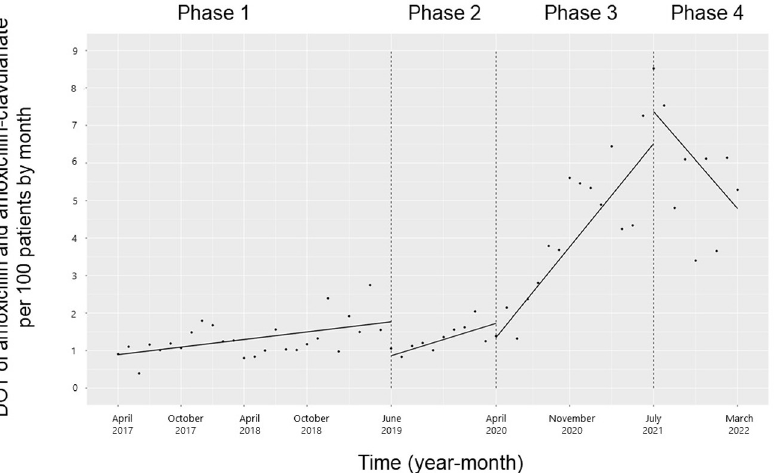
Fig 3. Trends in the days of amoxicillin and amoxicillin-clavulanate therapy per 100 patients, by month, during Phases 1 to 4. Each dot refers to the amoxicillin and amoxicillin-clavulanate per 100 patients each month, and the slope is based on the linear regression in the four phases: Phase 1 (pre-intervention period from April 1, 2017, to May 31, 2019); Phase 2 (review of clinical pathways from June 1, 2019, to March 31, 2020); Phase 3 (establishing an ID consultation service and implementing the ASP from April 1, 2020, to June 30, 2021); and Phase 4 (educational lecture and pop-up displays for oral antimicrobials from July 1, 2021, to March 31, 2022).